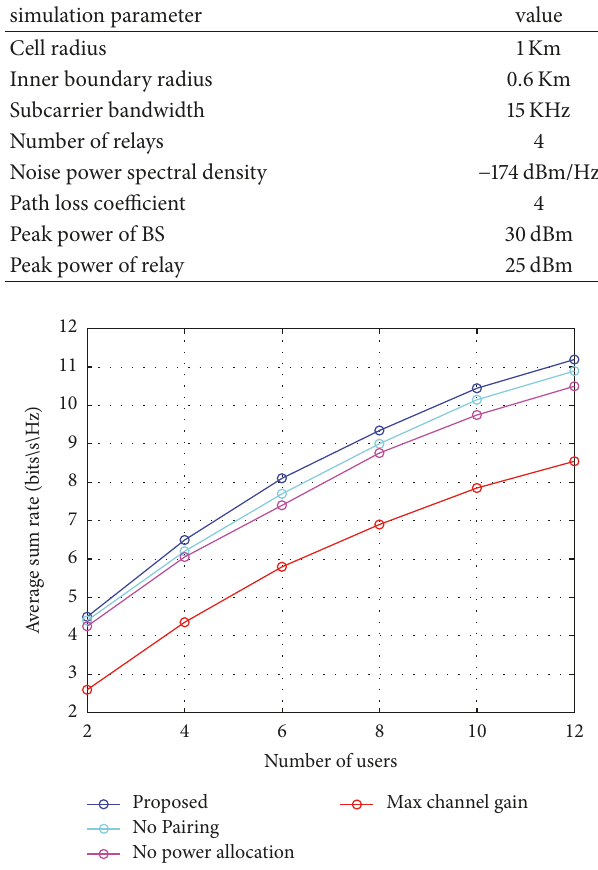
Figure 2: Operator’s profits versus different number of